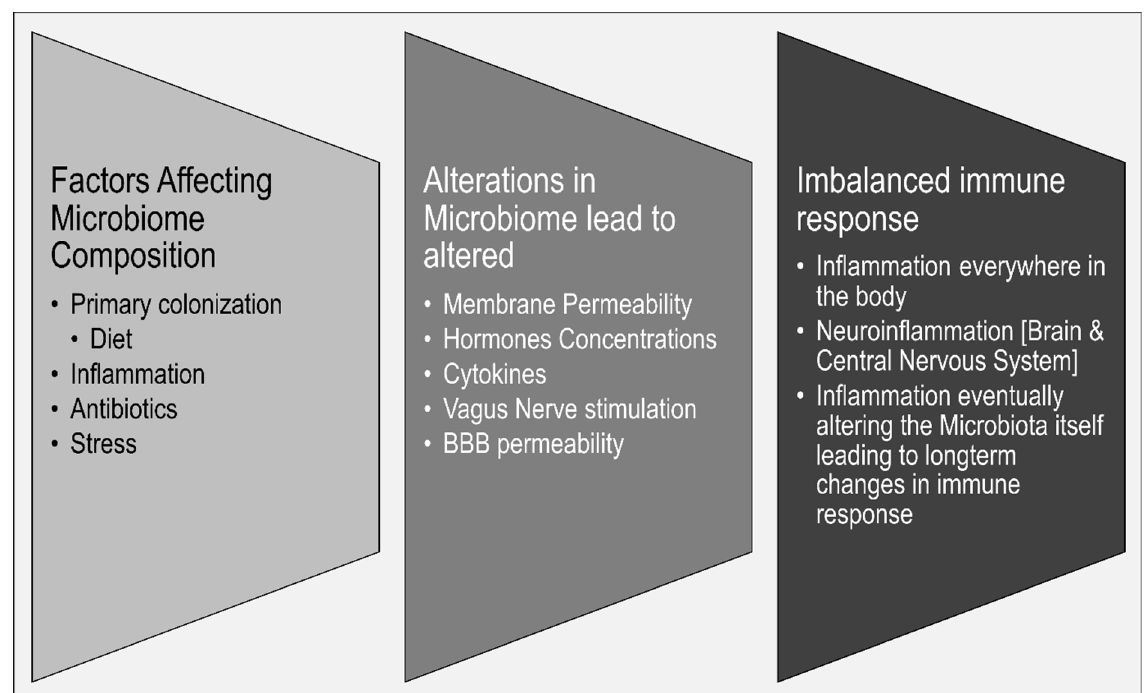
Figure 2. A summary of various factors that connect microbiome and neuroinflammation.